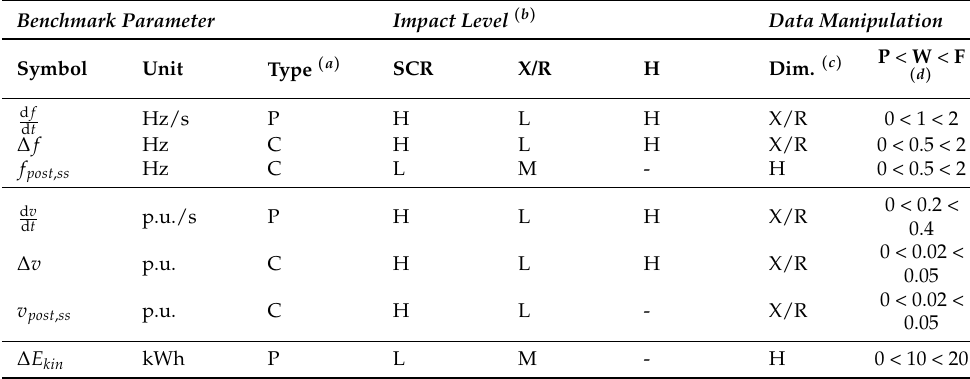
Table 4. Impacts of the compliance parameters.